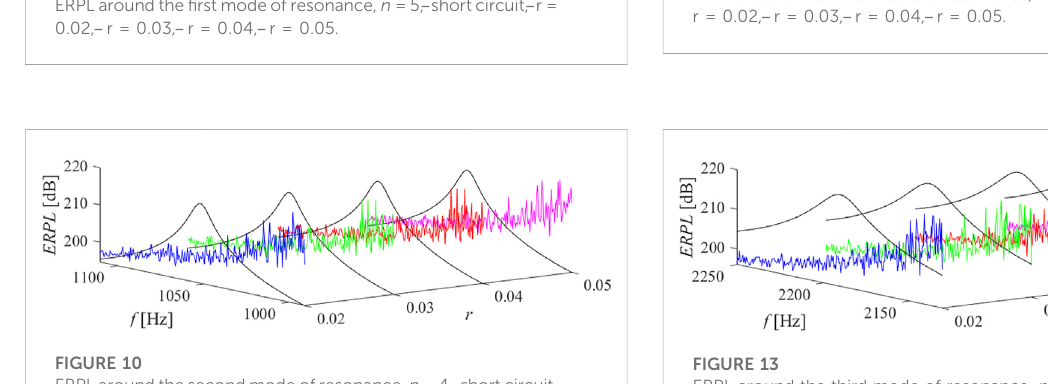
FIGURE 12 ERPL around the third mode of resonance, n = 4, ̶ short circuit, ̶ r = 0.02, ̶ r = 0.03, ̶ r = 0.04, ̶ r = 0.05.